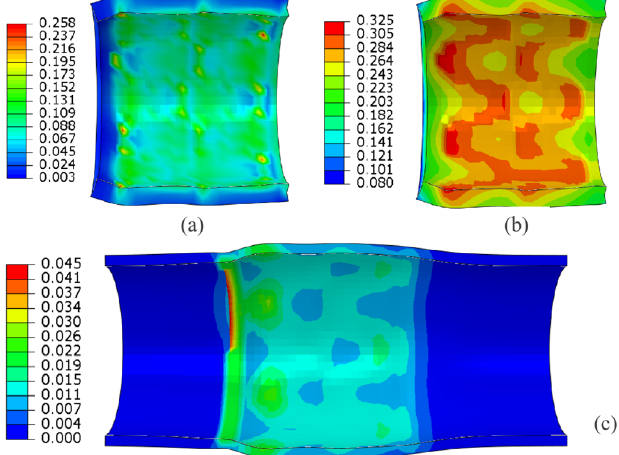
Figure 13. Distribution of equivalent stress ( a ), displacement ( b ), and equivalent stress ( c ) along the arterial wall after expansion of the stent.